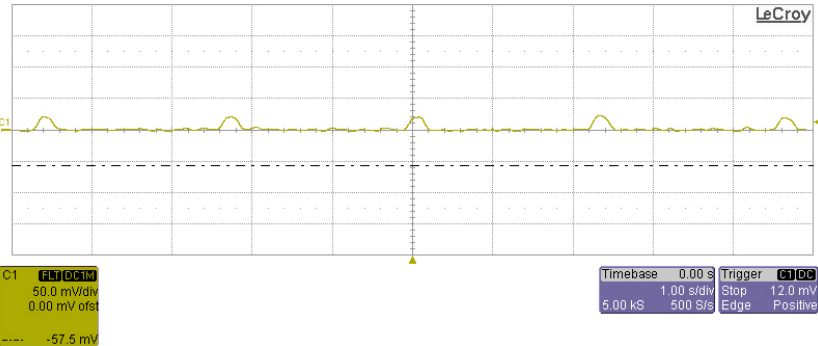
Figure 14. Oscilloscope record of power consumption (voltage over 1 Ohm resistor) during sleep mode. The peak current while reading the VOC sensor is 20.8 mA. Average power consumption in this